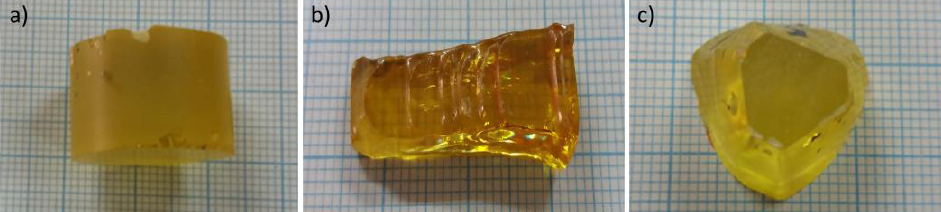
Figure 1. Photographs of the as-grown crystals ( a ) PGO + 0.1Ba, ( b ) PGO + 0.2Ba, ( c ) PGO + 0.25Ba.